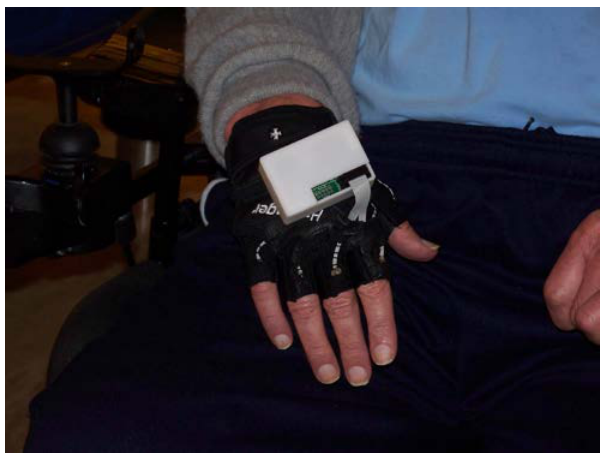
Fig. 1. The Mobile Music Touch glove uses vibration motors to stimulate each